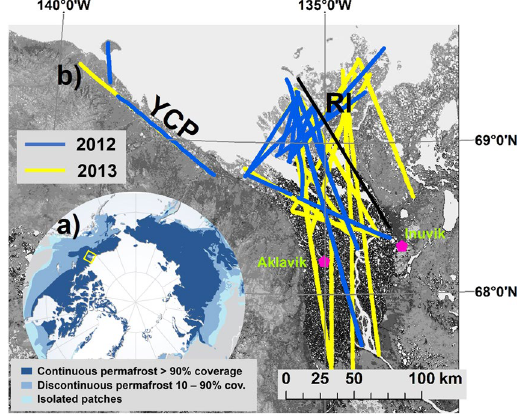
Figure 1. Study area and flight tracks. ( a ) Location of the study area and state of the permafrost (map modified after ref. 45), ( b ) flight tracks of two flight campaigns in 2012 and 2013 across the Mackenzie Delta, the adjacent Richards Island (RI) and the Yukon coastal plain (YCP). The black line marks the sharp transition between discontinuous permafrost in the delta to continuous permafrost on RI. The locations of the towns of Aklavik and Inuvik are shown for orientation. Data for background map from ref. 46. The map in Fig. 1b was created using ArcGIS software ArcMap 10.1 by